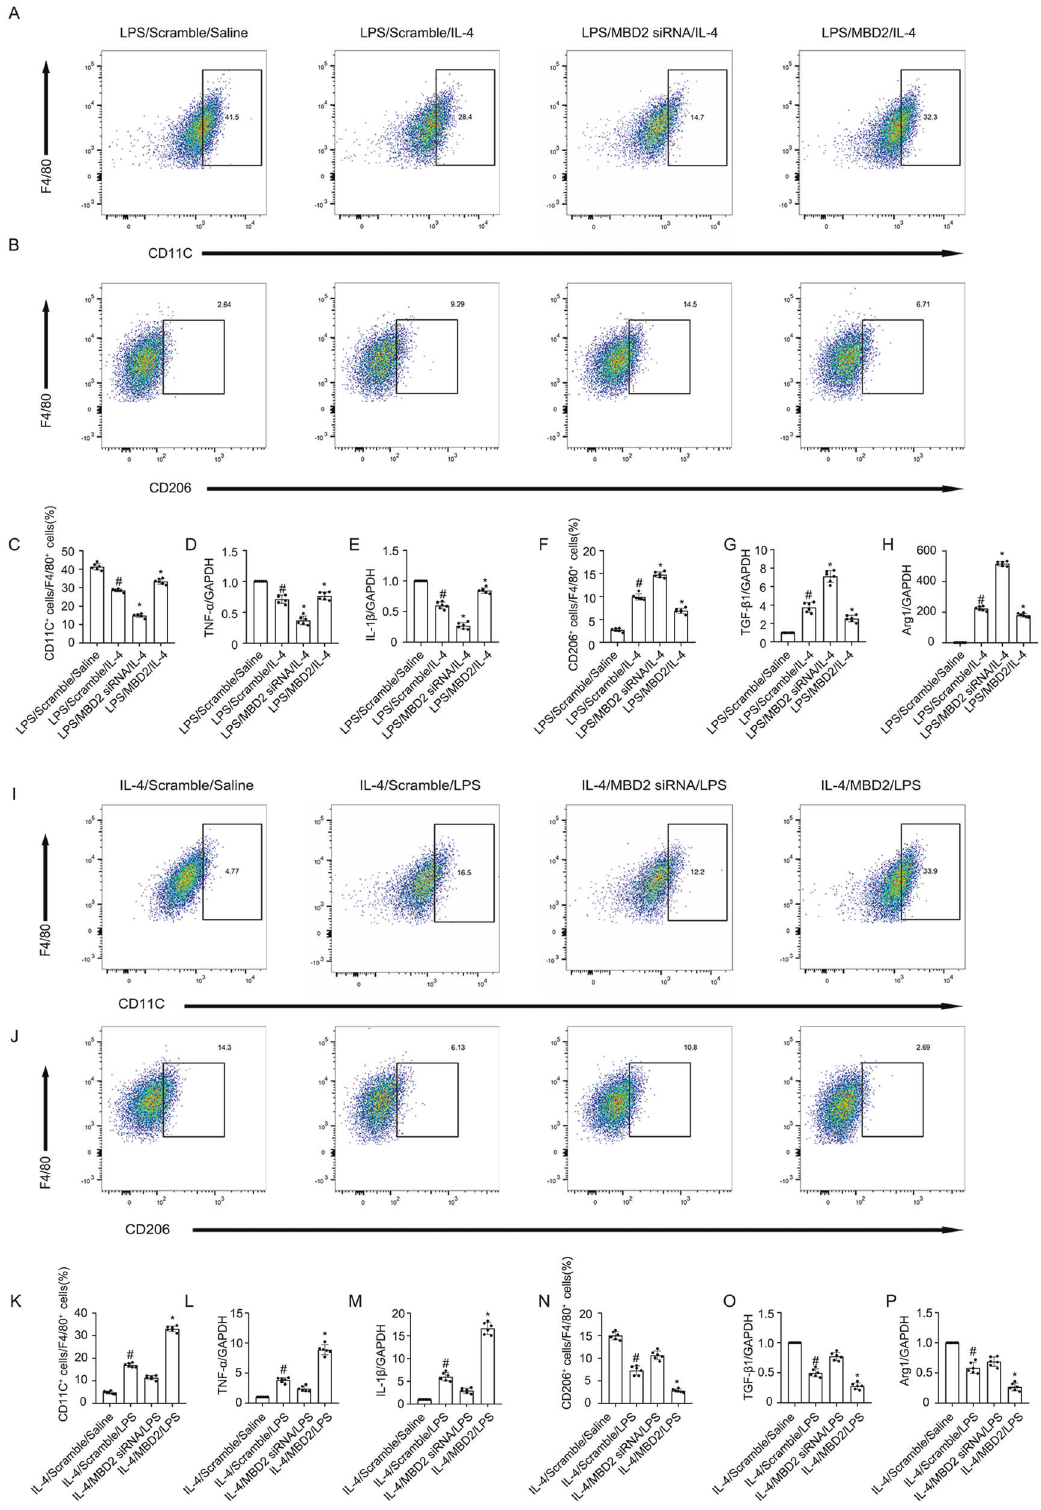
Fig. 3 MBD2 promoted transition of M2 to M1. RAW264.7 macrophage cells were transfected with MBD2 siRNA or MBD2 plasmid plus with LPS 1 μ g/ml or IL-4 20 ng/ml treatment for 24 h. A , C , I , and K Representative FCM analysis the ration of M1 (CD11C + cells vs. F4/80 cells). B , F , J , and N Representative FCM analysis the ration of M2 (CD206 + cells vs. F4/80 cells). D and L The expression levels of TNF- α were detected by real-time qPCR. E and M The expression levels of IL-1 β were detected by real-time qPCR. G and O The expression levels of TGF- β 1 were detected by real-time qPCR. H and P The expression levels of Arg1 were detected by real-time qPCR. # P < 0.05 versus Scramble plus LPS or IL-4 group. Data are expressed as means ± sd ( n = 6). * P < 0.05 versus LPS and IL-4 group.